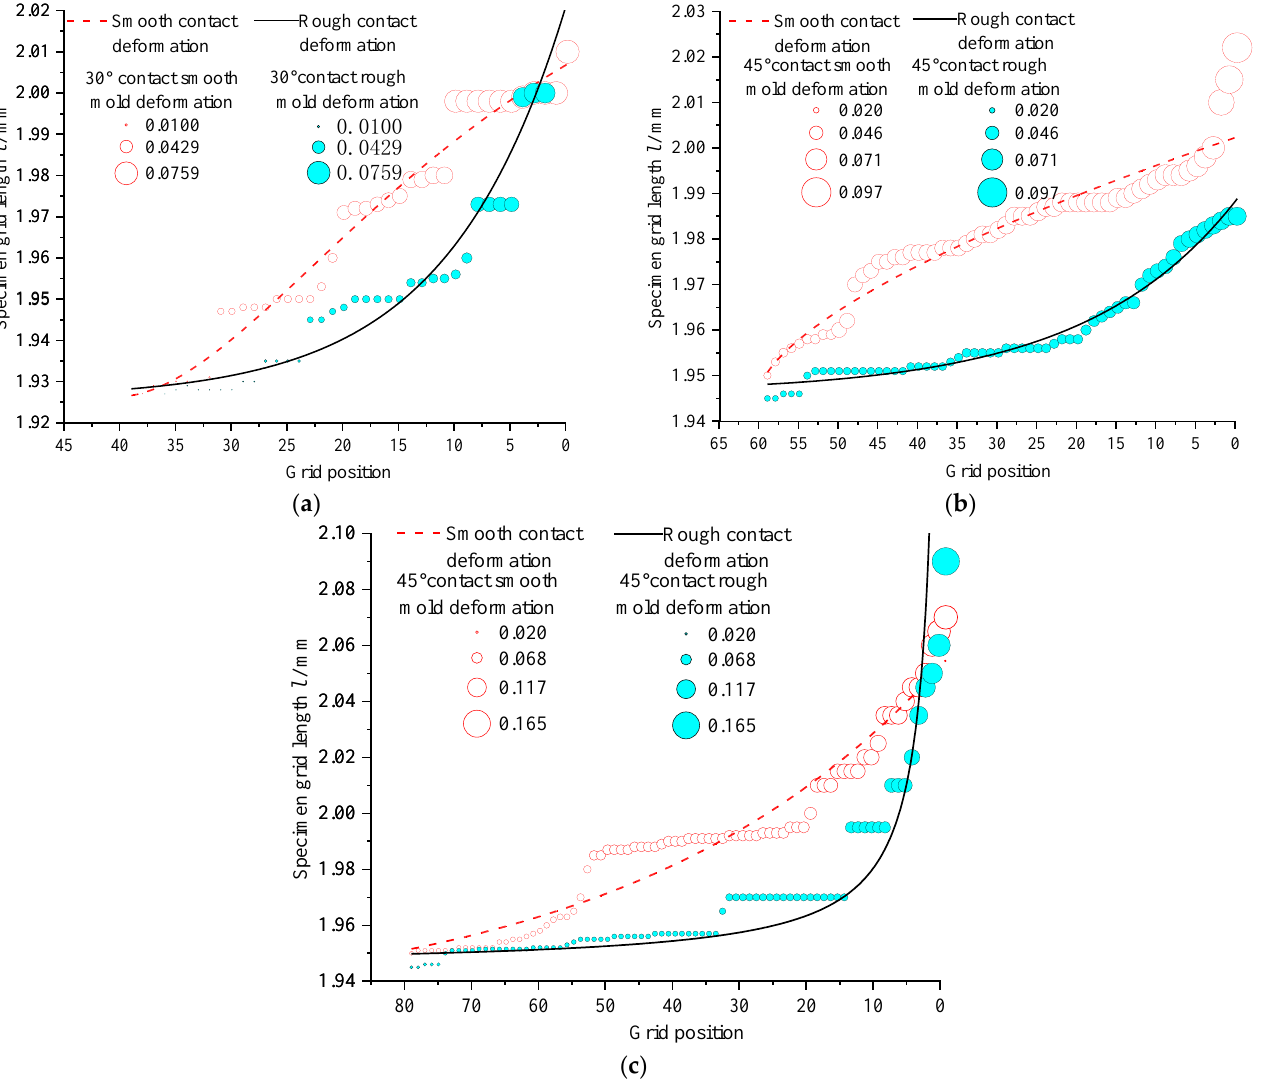
Figure 15. Strain grid length and deformation distribution of the contact mold segment. ( a ) 30° contact mold angle; ( b ) 45° contact mold angle; ( c ) 60° contact mold angle.